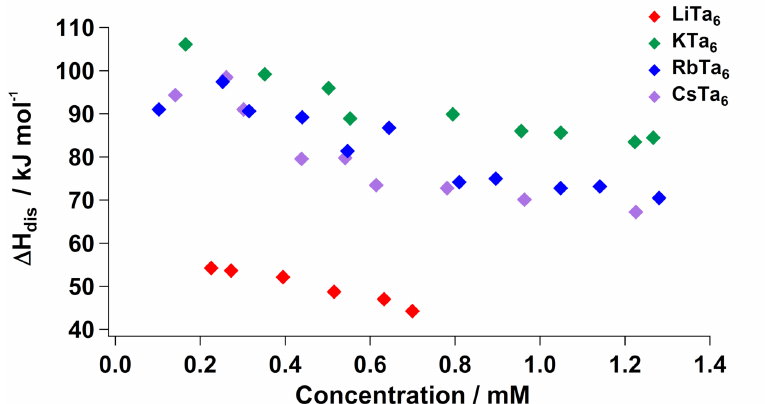
Figure 2. Enthalpy of aqueous dissolution ( ∆ H dis ) of Li–Ta normalized for lattice water (i.e., representing dissolution of the dehydrated forms Li K [Ta O ], Rb [Ta O ] and Cs [Ta O ]; the hydrated enthalpies are provided in Tables 8 6 19 8 6 19 8 6 19